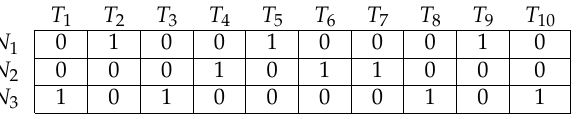
Figure 2. Example of the position